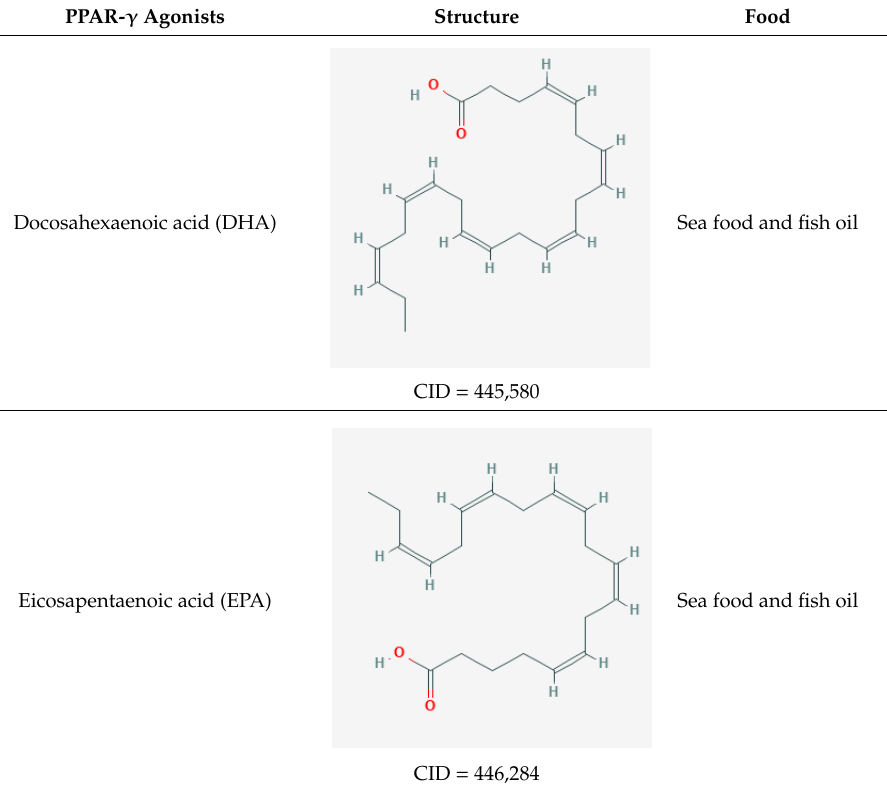
3.7. Lemongrass Lemongrass is a perennial herb used mainly for the extraction of its oil, which is used as an aroma in the kitchen and as a fragrance in cosmetics. Lemongrass has been used for years, especially in Southeast Asia, for its analgesic and anti-inflammatory properties [59]. Lemongrass oil contains citral, which gives it the distinctive aroma and perfume and is a mixture of aldehydes that have the same molecular formula but different structure, the trans isomer geranial and the cis isomer neral. Citral activates PPAR- γ , which inhibits the expression of pro-inflammatory cytokines, such as IL-1 β and IL-6, and suppresses the activity of the COX-2 promoter [60]. Table 1. Nutritional agonists of PPAR- γ . The table summarizes the main nutrients activator of PPAR- γ The chemical structure of the natural ligands of PPAR- γ has been collected from PubChem [45] and their chemical structures. and is reported in Table